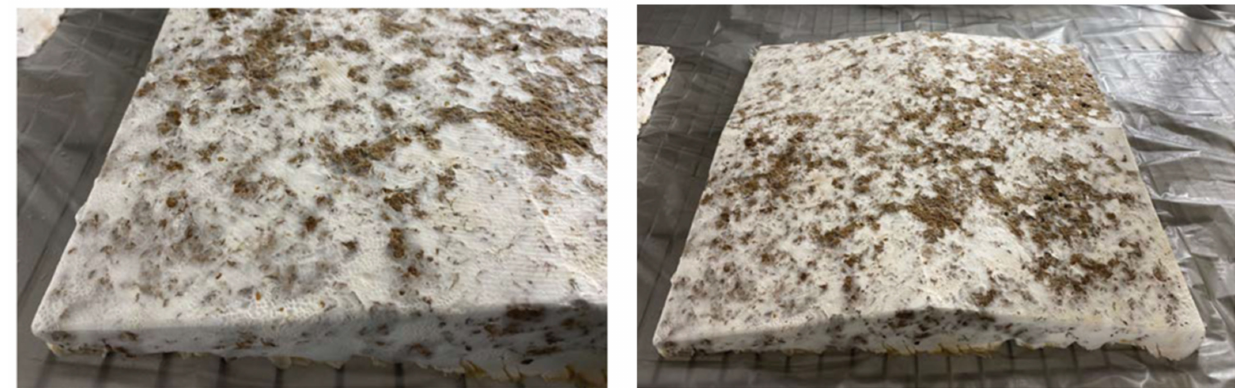
Figure 13. Acoustic panel prototype cultivated with Fine Cardboard substrate.